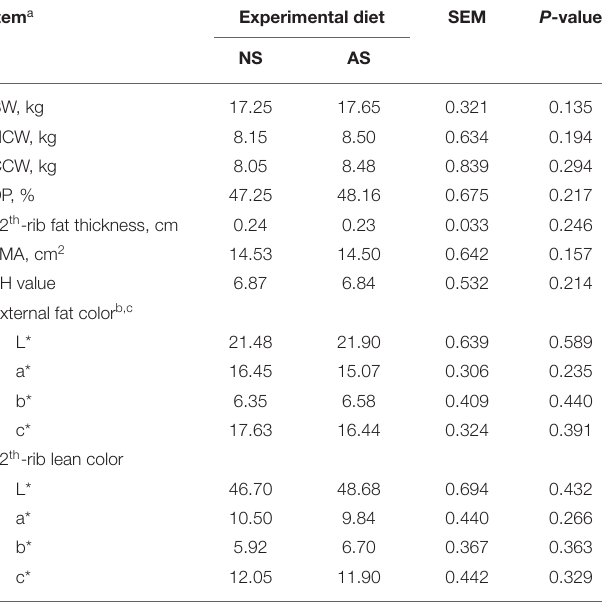
a BW, body weight; HCW, hot carcass weight; CCW, cold carcass weight; DP, dressing percentage; LMA, LM area measured at 12 th rib; SEM, standard error of mean. b Fat color measurements obtained approximately 20cm ventrally to the lateral process of the split carcass adjacent the 13 th rib. c CIE color measurements: L * = lightness, black (0) to white (100); positive a * = red; negative a * = green; positive b * = yellow; negative b * = blue; c * = color saturation =